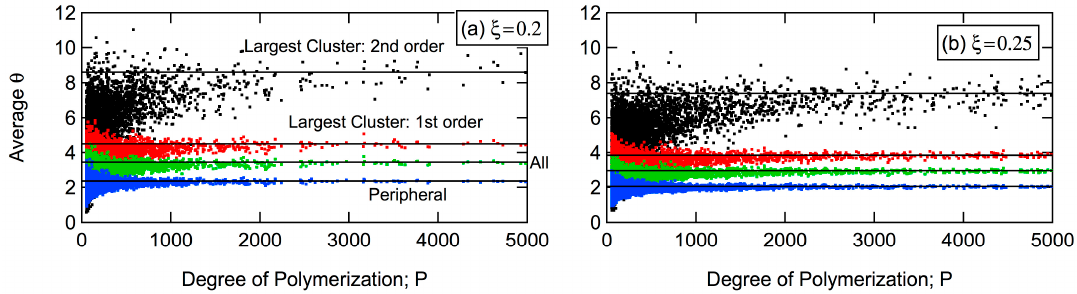
Figure 10. Average residence time of the units in the largest tri-branched cluster of the second order (black dots), of the units in the largest tri-branched cluster of the first order (red), of all units (green), and of the peripheral T units (blue) for the cases with r = ∞ . ( a ) ξ = 0.2, and ( b ) ξ = 0.25.